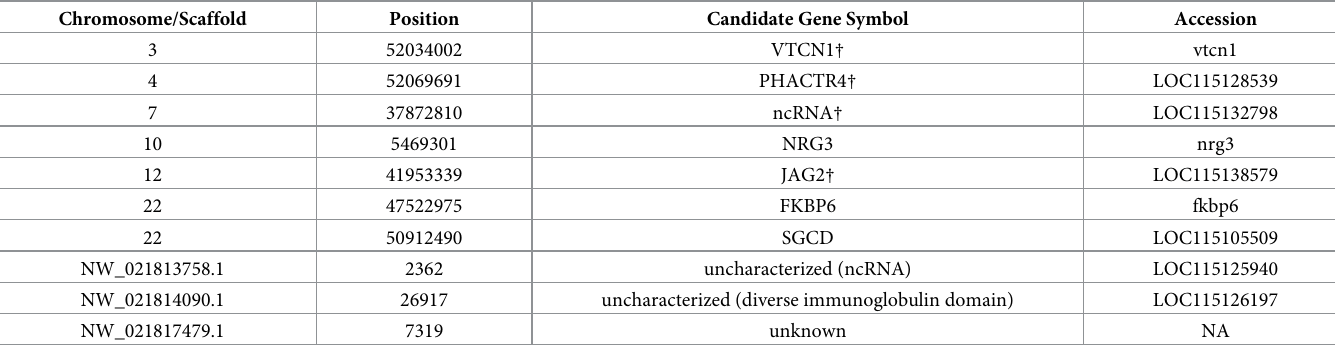
Table 3. Genomic locations of ecotype associations. Chromosome/Scaffold